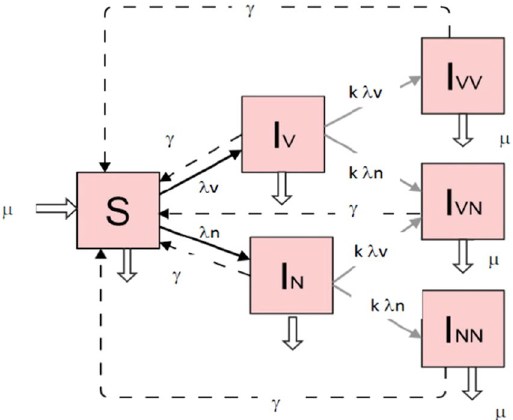
Figure 1. Model flow diagram in the absence of vaccination. S, susceptible, I V , single carriers of any vaccine serotype, I N , single carriers of any non-vaccine serotyoe, I VV double carriers of any two vaccine serotypes, I NN , double carriers of any two non-vaccine serotypes, I VN , double carriers of a vaccine and non-vaccine serotype. With vaccination, the structure of the model is doubled to account for vaccination status of each epidemiological class. The parameters are defined in the text. See Methods 1–3 for details, and Supplementary Material S1 for full ODE equation